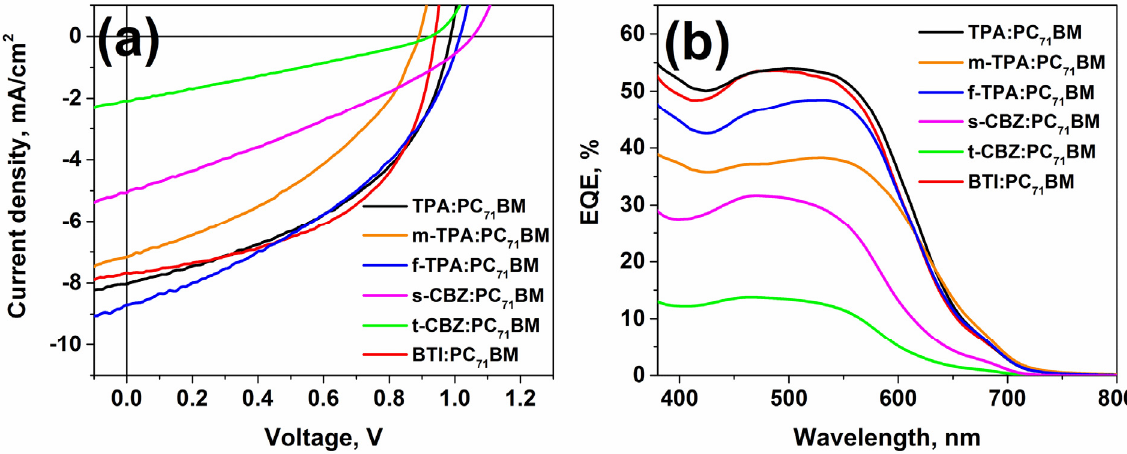
Figure 8. J-V curves under AM1.5G illumination (100 mW/cm 2 ) ( a ) and EQE spectra ( b ) for BHJ solar cells. Table 6. The best photovoltaic parameters of BHJ solar cells under AM1.5G illumination (100 mW/cm 2 ), maximum EQE values. Active Layer Material J SC , mA/cm 2 J SC EQE a , mA/cm 2